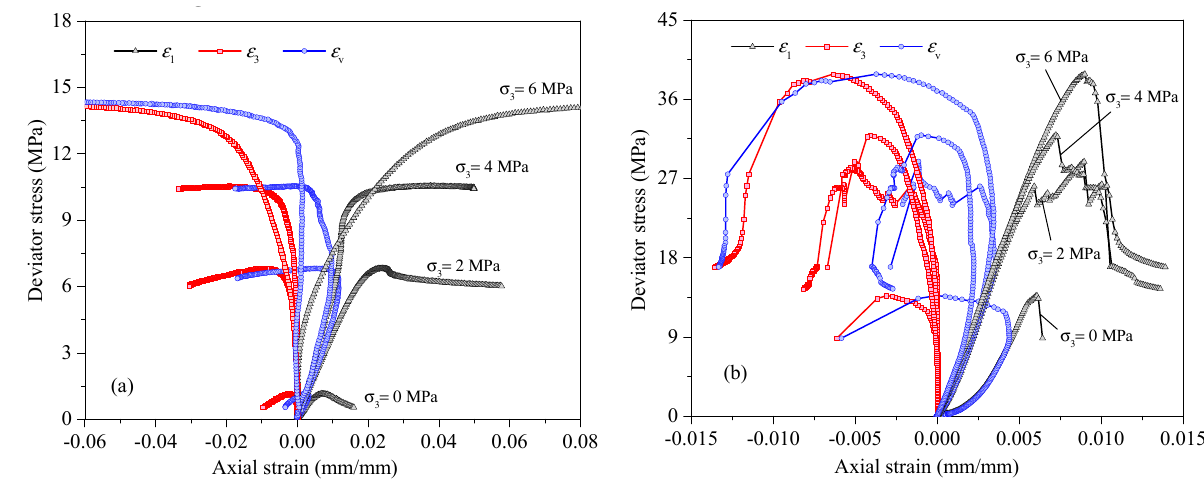
Figure 13. The deviator stress − strain curves of different coal under triaxial condition. ( a ) RTC; ( b ) intact coal.